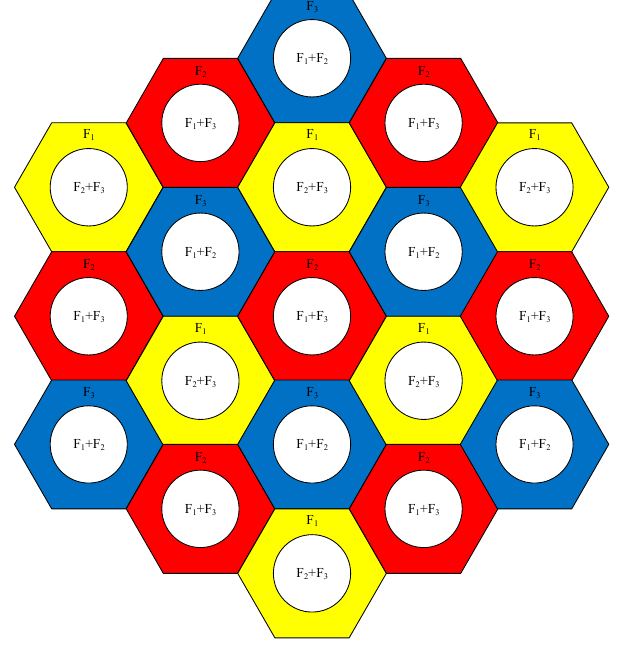
Figure 2. Deployment of base stations and channel assignment.